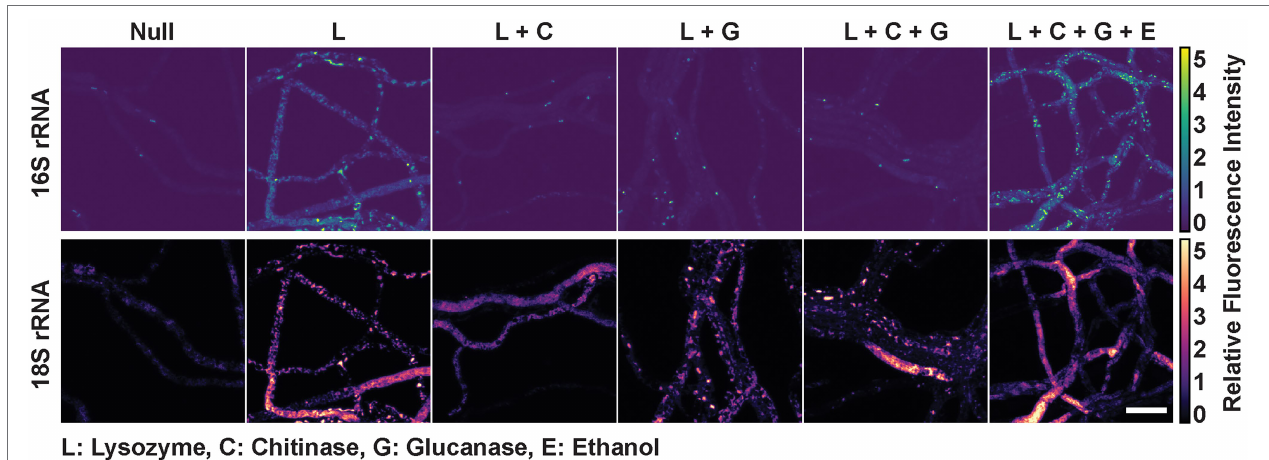
FIGURE 2 | Mycoavidus bacterium observed in Podila verticillata , LANL.1351.123, by rRNA FISH imaging after exposure to different permeabilization treatments. Relative fluorescence intensity images are scaled to the minimum and maximum pixel intensities of image sets (across) for 16S rRNA or 18S rRNA staining (top and bottom, respectively). Chemical or cell wall digestion enzymes treatments are designated by the single letter codes with key provided. Scale bar is 10 μ